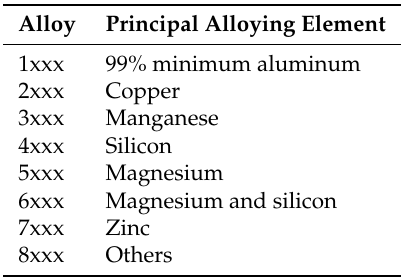
Table A1. Principal alloying element for wrought aluminum alloys.